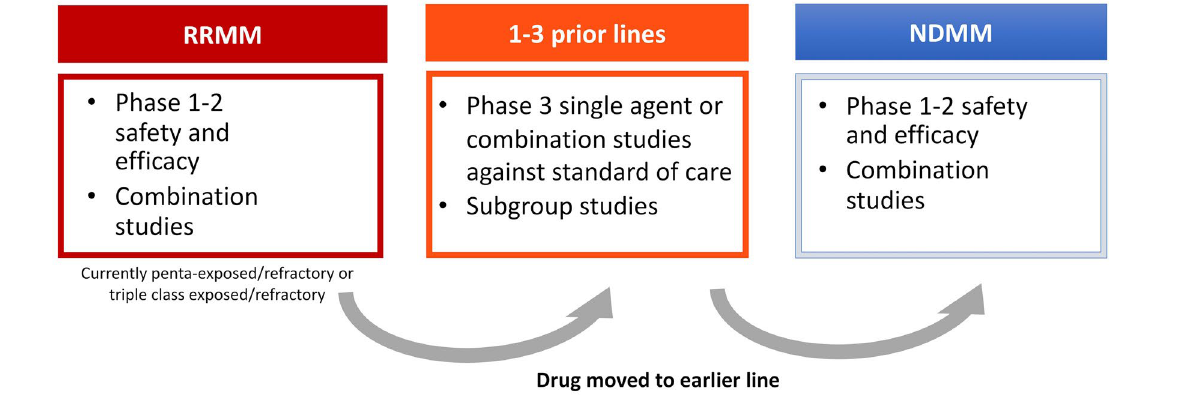
Figure 3. Traditional flow of drug development in